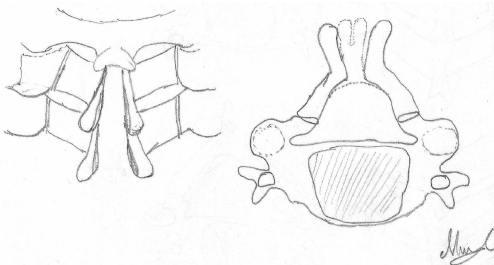
Figure 2: French door style of laminoplasty, the spinous process is split in the midline and the laminae hinged bilaterally, thereby expanding the spinal canal. Figures redrawn from Steinmetz and Resnick